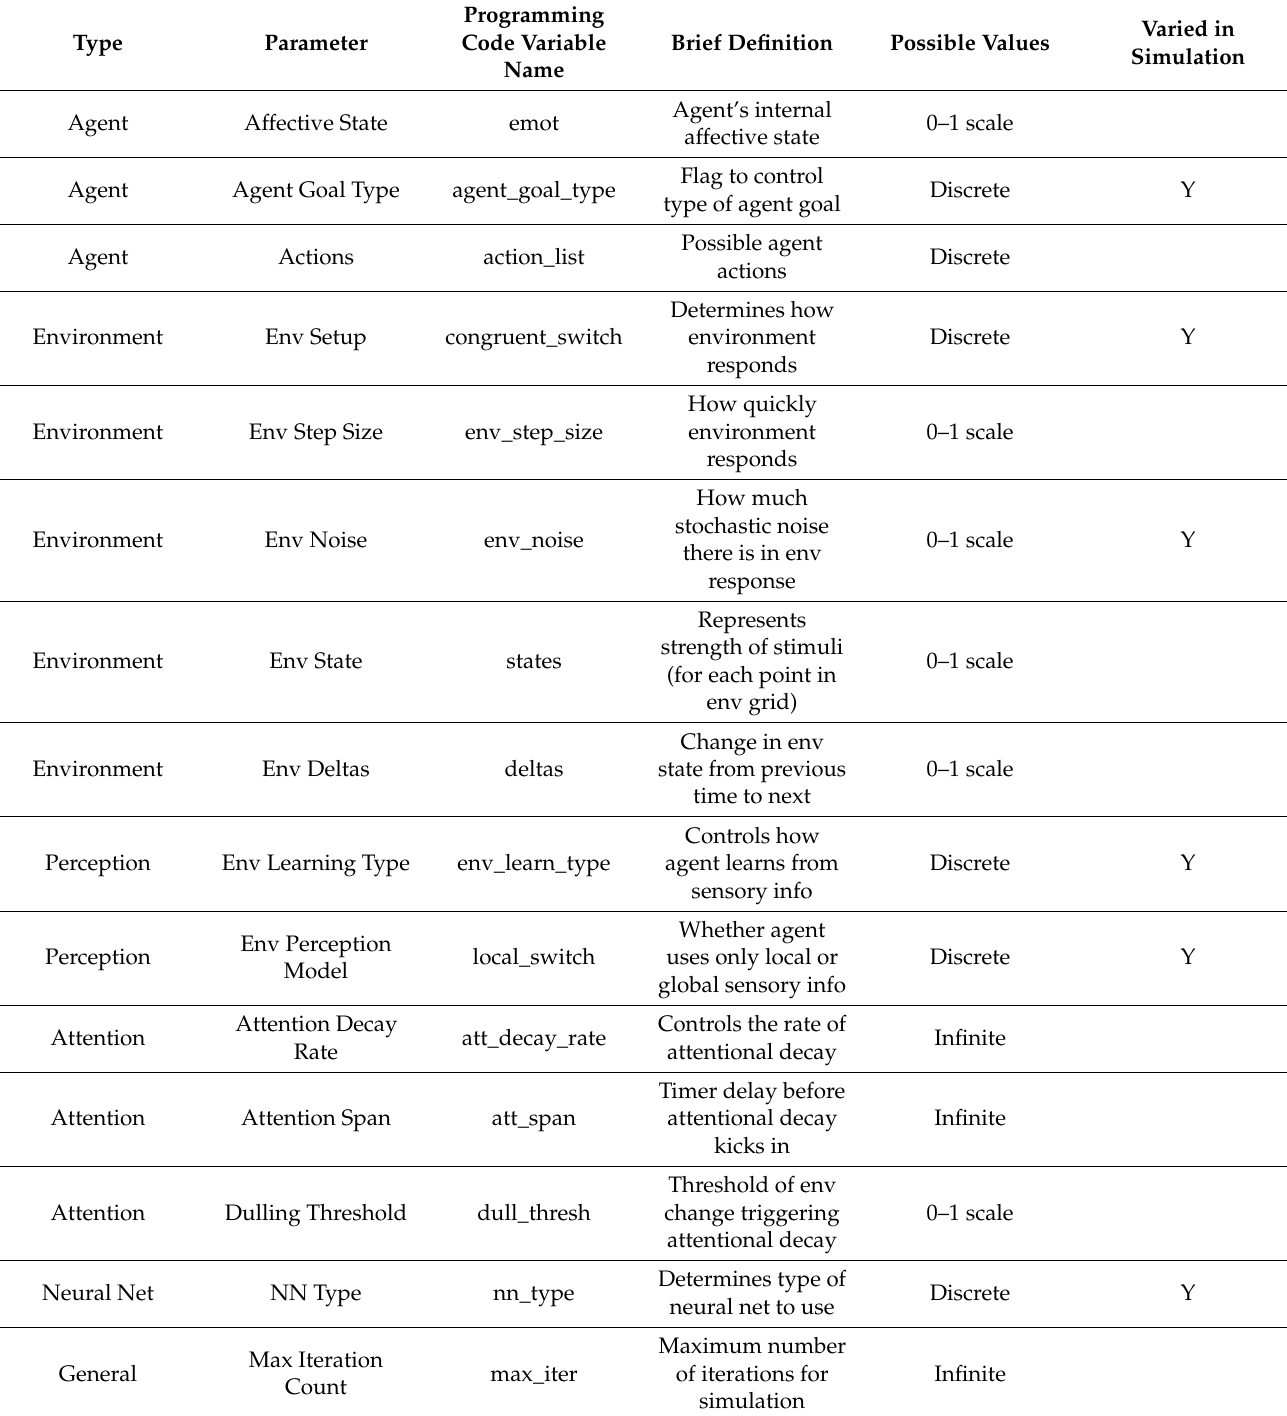
Table 1. Parameter